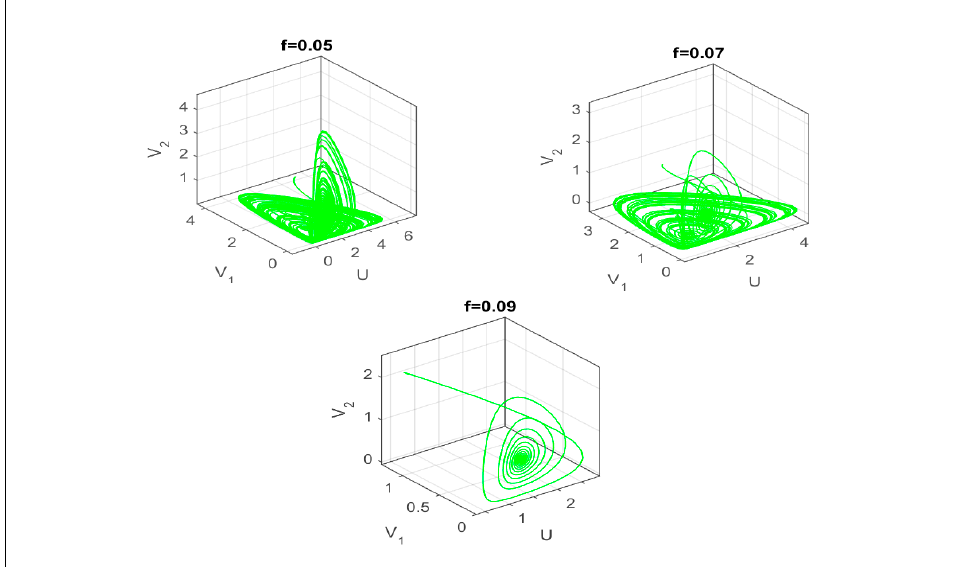
Figure 3. Phase portrait at different values of common resource f .